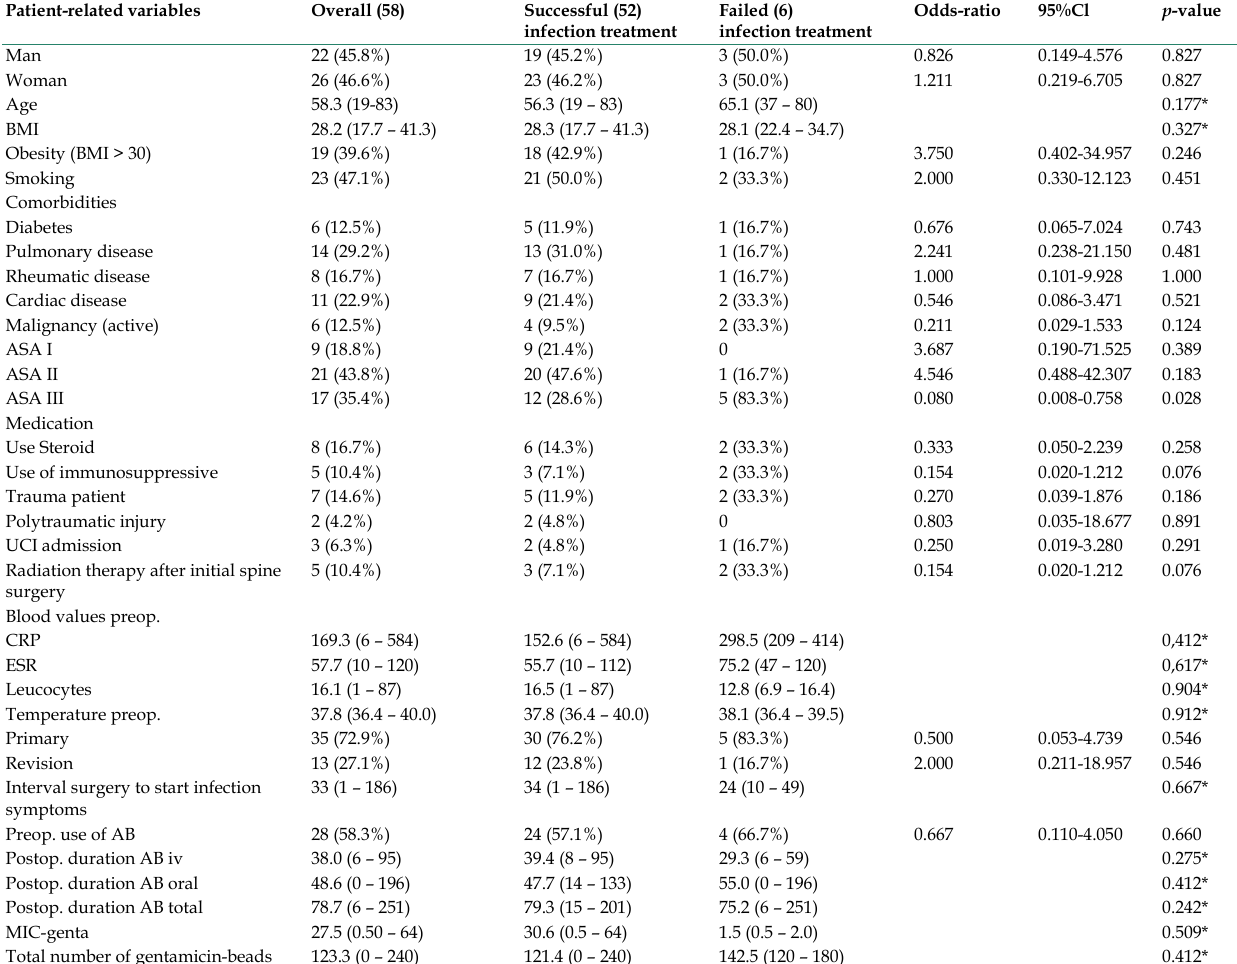
Table 3. Patient related